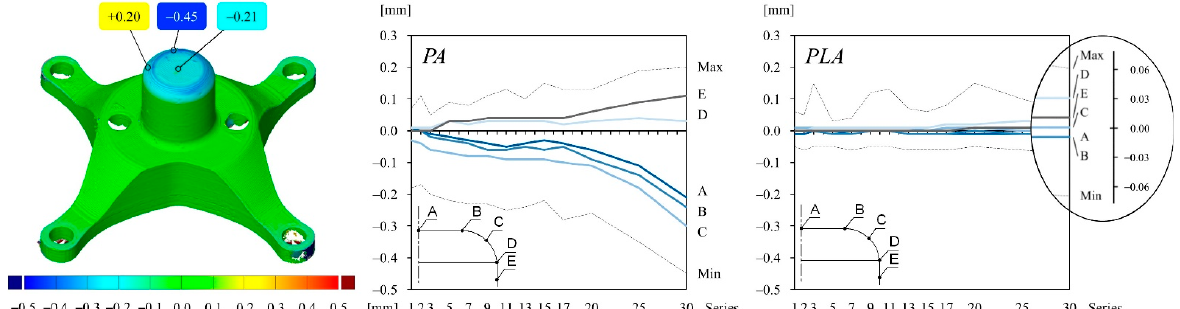
Figure 8. Deviation values (wear) of different measuring points on the stamp surface compared to the initial stamp geometry of both material configurations: ( left ) selected measuring points; ( middle ) deviation values of PA stamp over the course of 30 drawing operations; ( right ) deviation values of PLA stamp over the course of 30 drawing operations. The drawing inside the diagram indicates the location of the measuring points on the punch